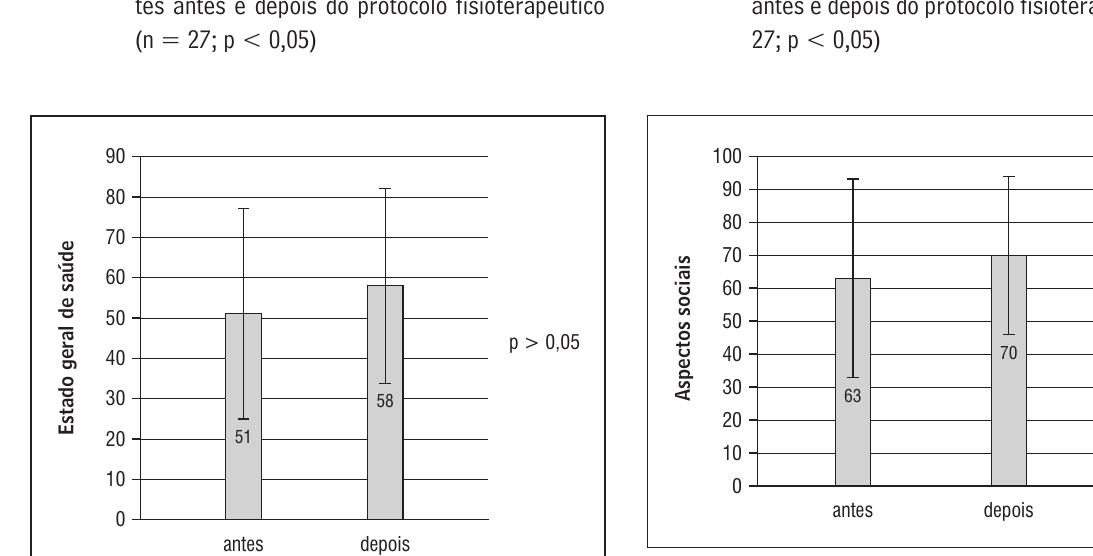
Figura 6 - Média e desvio-padrão dos aspectos sociais dos pacientes antes e depois do protocolo fisiotera- pêutico (n = 27; p > 0,05)